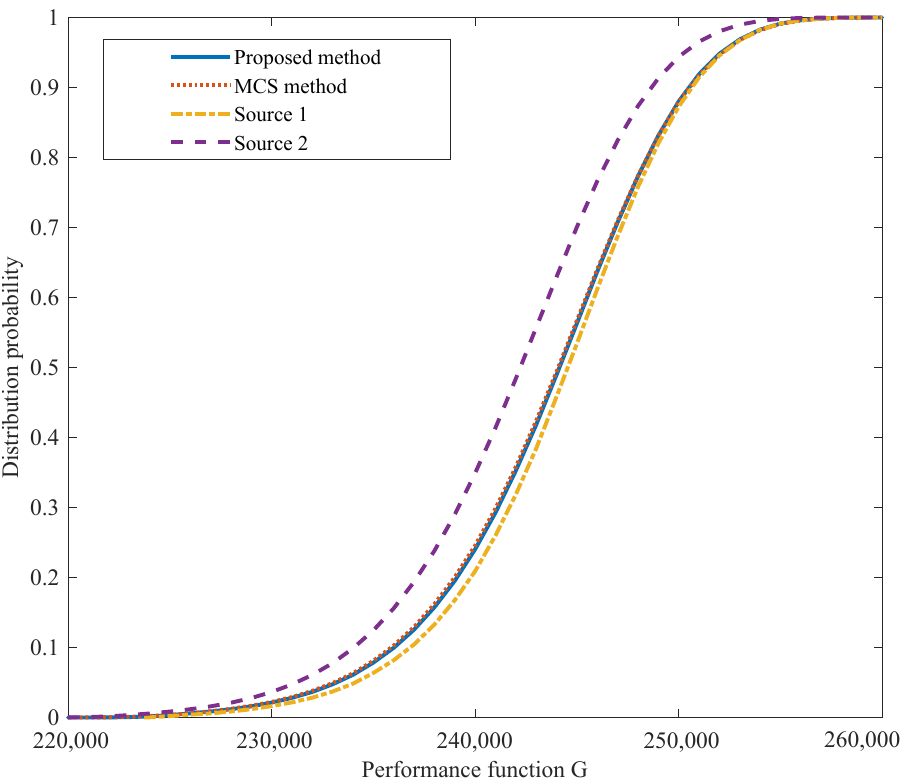
Figure 4. Reliability analysis results.